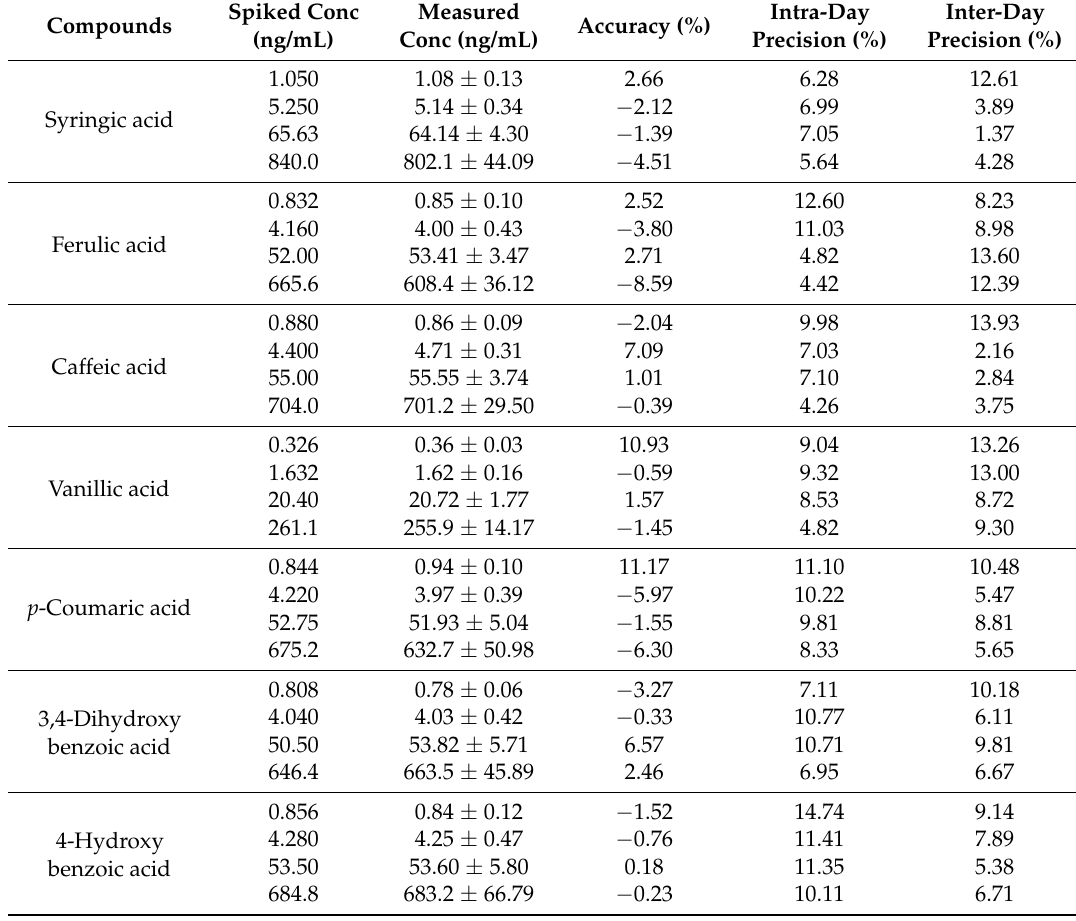
Table 1. The intra-day and inter-day precision and accuracy of the seven analytes. Spiked Conc Measured Compounds (ng/mL)